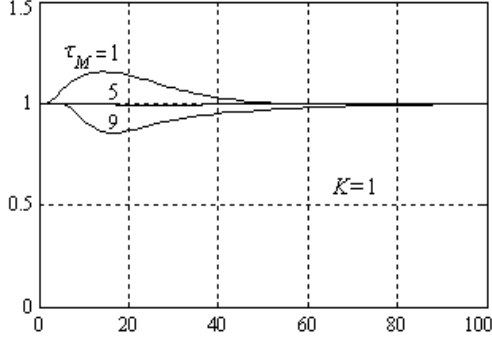
Figure 7. Control responses c ( t ) to a unit step setpoint for K M = 1, T sM = 53 and various τ M